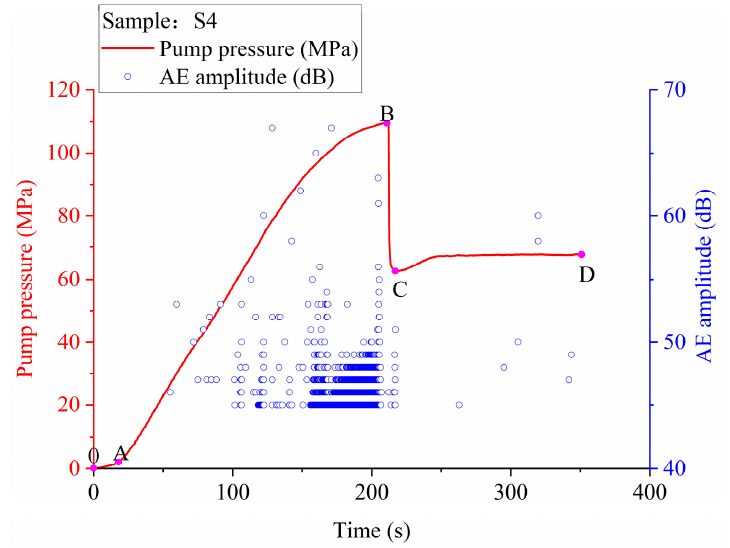
Figure 6. The relationship between pump pressure, AE amplitude, and injection time of sample S4.